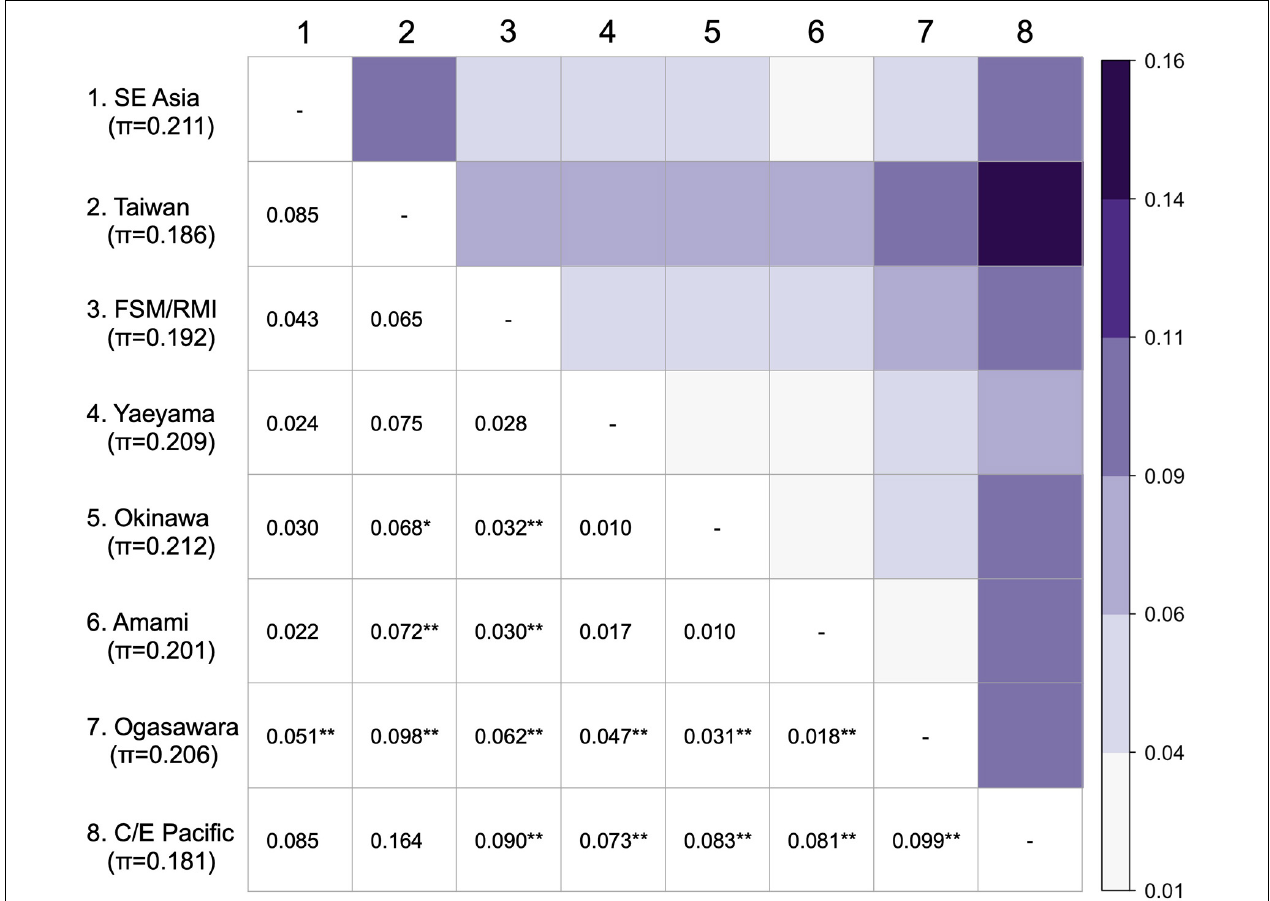
FIGURE 3 | Population pairwise F ST values (below the diagonal) and heatmap of populations drawn by the F ST values (above the diagonal). The superscripts * and ** on the F ST values denote significance levels of < 0.05 and < 0.01, respectively. The average nucleotide diversity ( π ) of each population is indicated below the